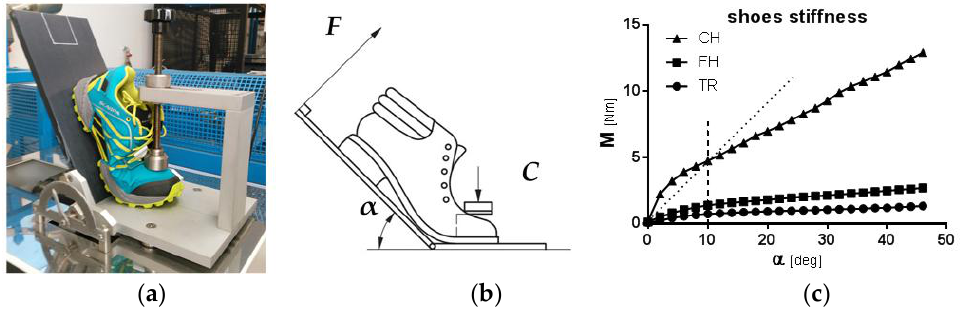
Figure 2. Bending test set-up (EN ISO 20344:2011): ( a ) stiffness bench test working; ( b ) schematic representation of the stiffness test. α : bending angle; F : bending force; C : clamping force; ( c ) the bending angle α is reported on the x-axis, whereas the corresponding bending moment M , coming from the bending force F , is shown in the y-axis. The secant relative to the CH footwear at 10 degrees is also plotted: its slope is the sole bending stiffness 𝐾 𝐹𝑠10 𝑀𝑇𝑃